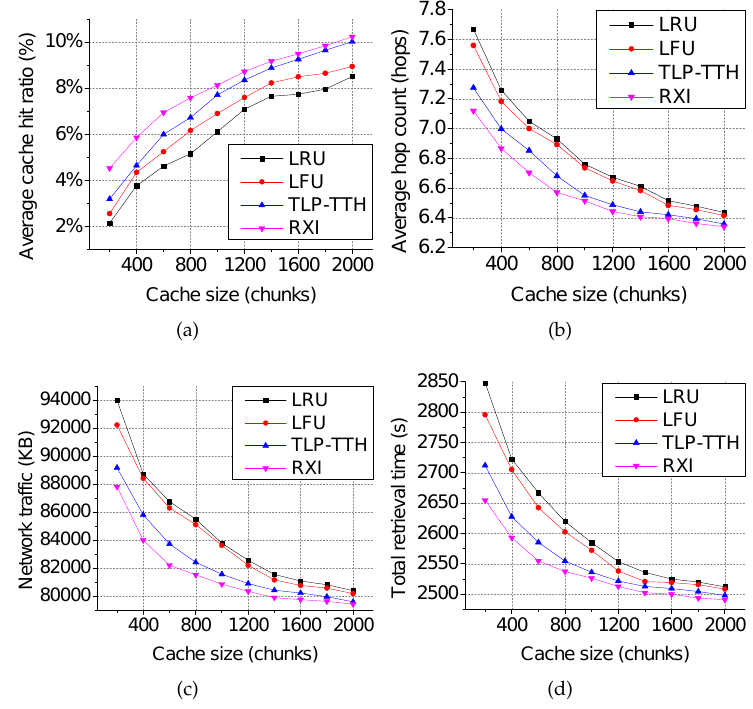
Figure 6. Simulation results of hierarchical topology. ( a ) average cache hit ratio; ( b ) average hop count; ( c ) network traffic; ( d ) total retrieval time. LFU: Least Frequently Used; TLP-TTH: Two-level popularity oriented time-to-hold